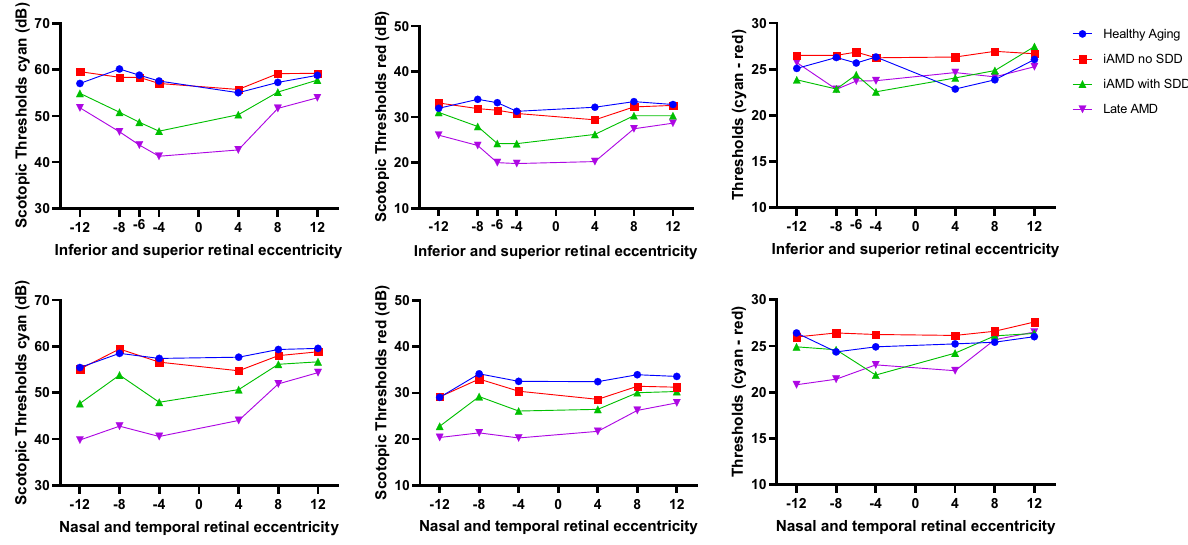
Figure 5. Scotopic thresholds thresholds at 4°, 8° and 12° eccentricity superior, inferior, temporal and nasal to the fovea) plus one further location at 6° inferior in the vertical meridian are shown for cyan and red stimulus. Four additional locations covering 12° eccentricities in all the four retinal quadrants not shown for illustrative purposes. The panels on the right show the difference between cyan and red thresholds. Negative eccentricities correspond to the inferior and nasal retina, positive eccentrcities to the superior and temporal retina.Healthy aging (N = 11), iAMD no SDD (N = 17), iAMD with SDD (N = 11) and Late AMD (N = 11).